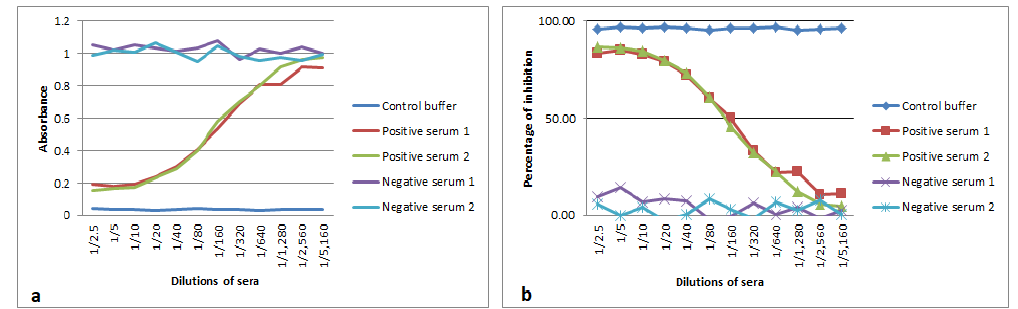
Figure 3. The smallest amount of specific antibodies against contagious caprine pleuropneumonia (CCPP) detected by CCPP blocking-ELISA (b-ELISA) in the sera samples tested. ( a ) The limit of detection for the new CCPP b-ELISA showed the dilution 1:160 for positive sera 1 and 2 (lines red and green). ( b ) The cut-off value for PI at 50 % as the limit of the detection for these two samples.